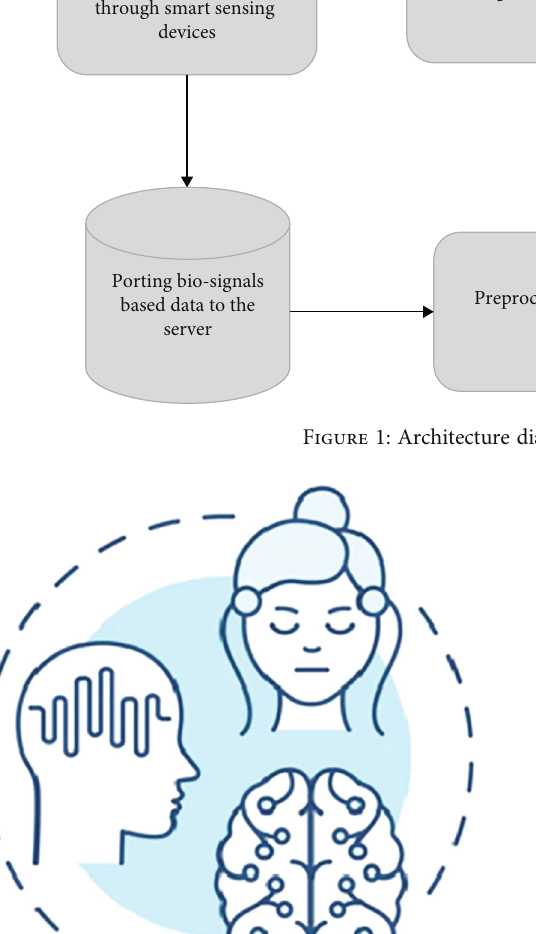
Figure 3: Types of EEG waves found in human